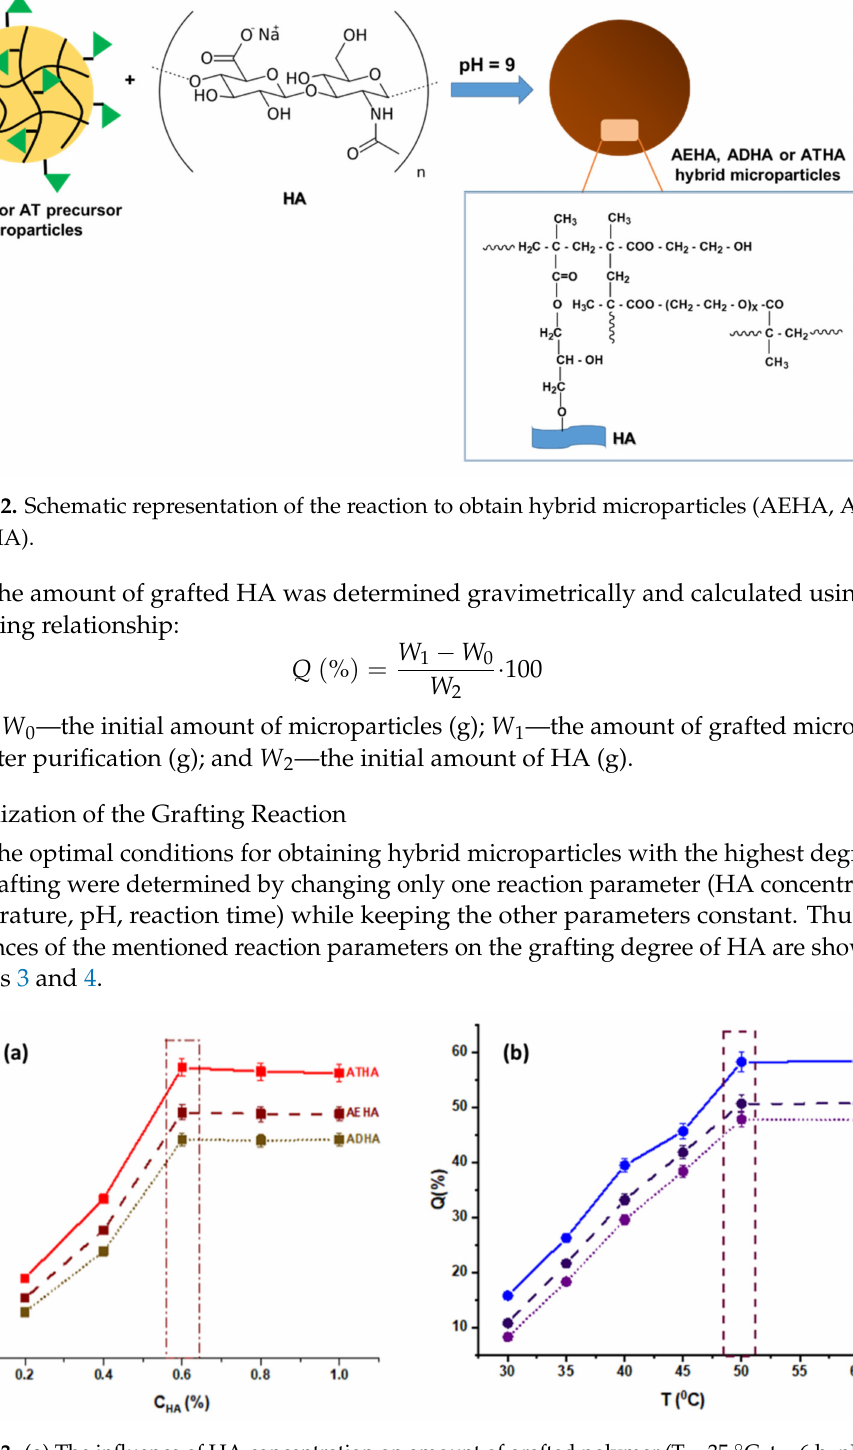
Figure 3. ( a ) The influence of HA concentration on amount of grafted polymer (T = 35 ◦ C, t = 6 h, pH = 9); and ( b ) the influence of temperature on amount of grafted polymer (C P = 0.6%, t = 6 h, pH =